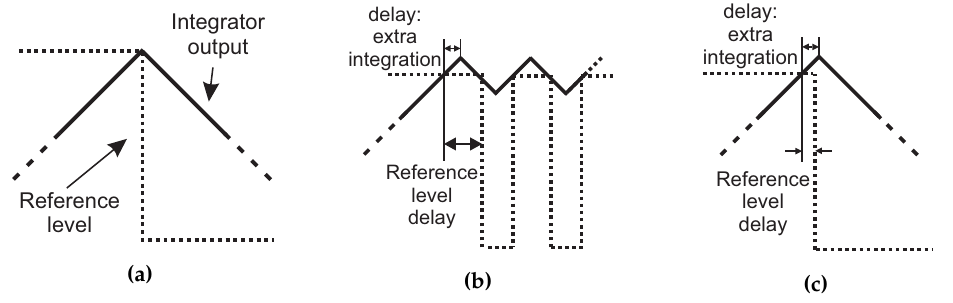
Figure 4. Transitions of both feedback loop. ( a ) Ideal case; ( b ) Deadlock situation; ( c ) No deadlock